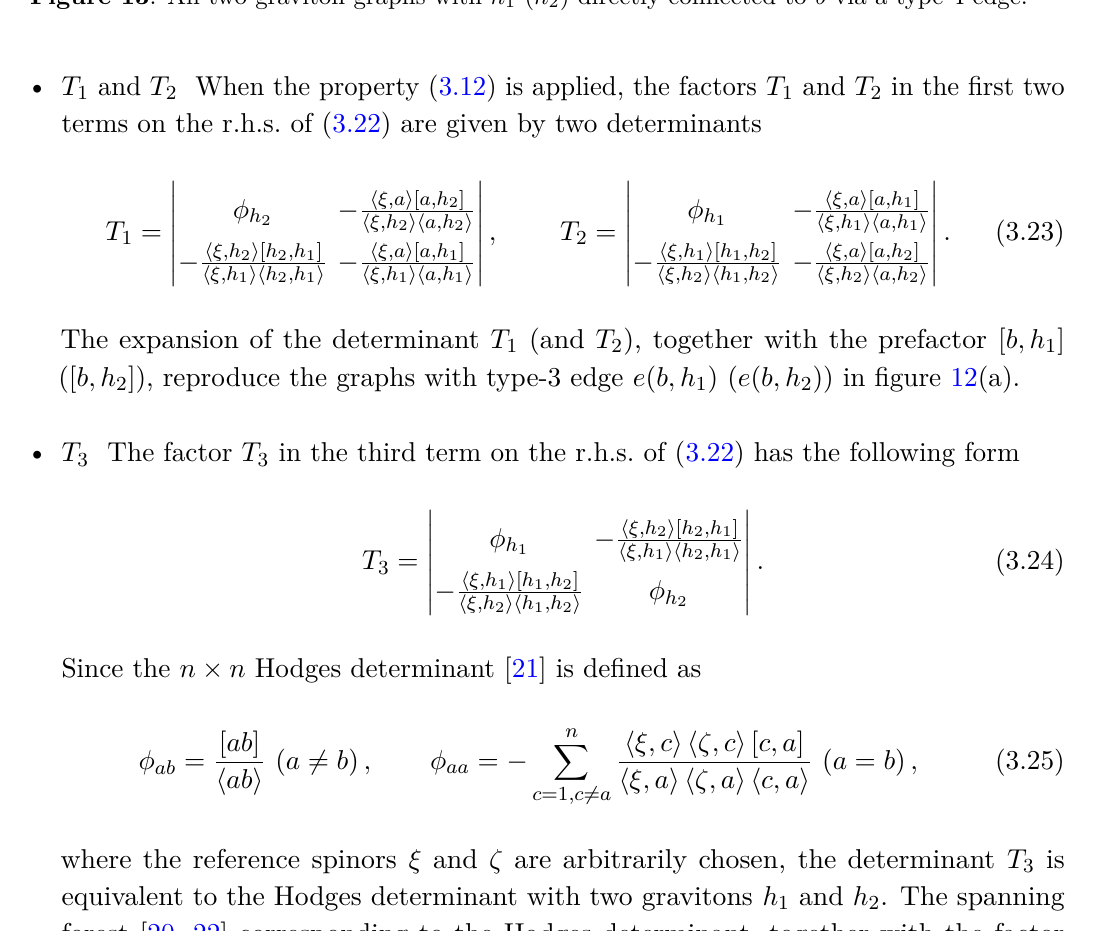
Figure 13 . All two-graviton graphs with h 1 ( h 2 ) directly connected to b via a type-4